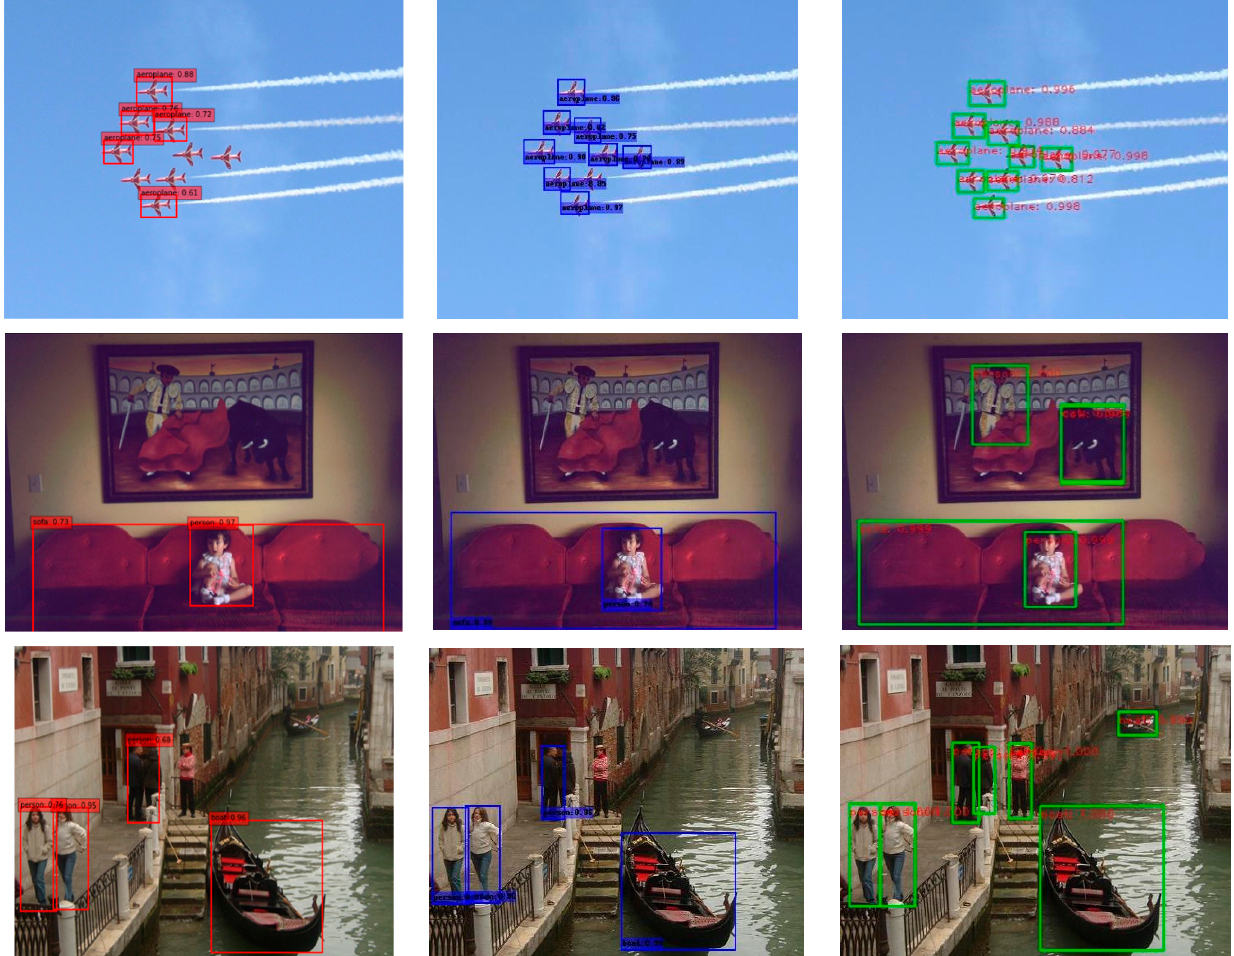
Figure 8. PASCAL 2007 test detection results (red detection boxes on the left show SSD321 detection results, blue boxes in the middle show DSSD321, and green detection boxes on the right show MS-DSSD321 detection results) .